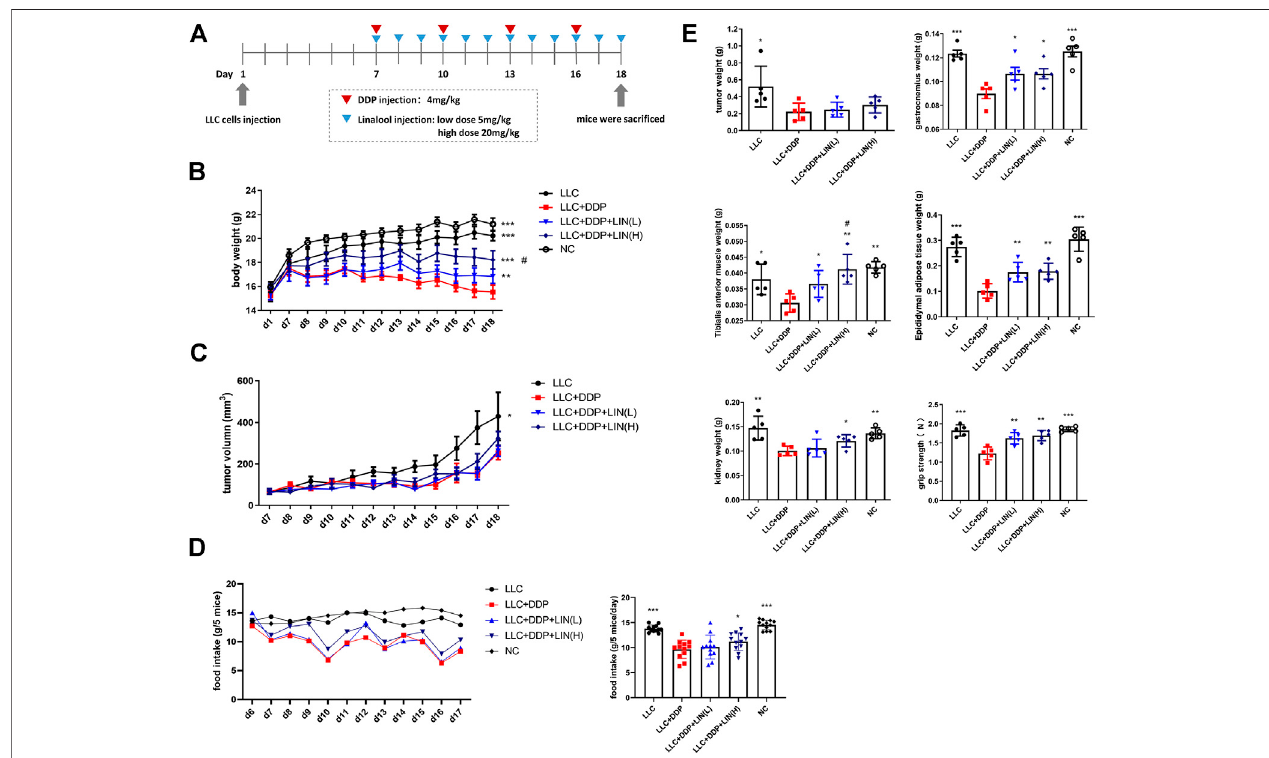
FIGURE 1 | LIN alleviated the decrease of body weight, food intake, muscle, adipose tissue, kidney weight and forelimb grip of tumor bearing mice after DDP treatmentwithoutaffectingtheanti-tumoureffectofDDP (A) 5-week-oldC57BL/6miceweretreatedwithDDP(4 mg kg − 1 · 3 days − 1 ,i.p.)andgivenhighandlowdoseof LIN (5, 20 mg kg − 1 · d − 1 , i.p.) atthe same time lasted for 12 days (B) Bodyweightwasmeasured on day 1and day 7 – 18(n (cid:2) 60); ** p < 0.01, *** p < 0.001vs. LLC +DDP group, # p < 0.05 vs. Group LLC + DDP + LIN(L). (C) The tumor size was measured daily on day 7-18. (D) Food intake of each group of mice was measured daily form one daybeforedosing totheend (left panel). Dataareshown asmean ± S.E.M. (n (cid:2) 12); * p < 0.05, *** p < 0.001 vs.LLC + DDPgroup. (E) Mice weresacri fi ced, the tumor, gastrocnemius muscle, tibial anterior muscle, epididymal fat, and kidney were collected and weighed, and the forelimb grip strength was measured before the mice were sacri fi ced. Data are shown as mean ± S.E.M. (n (cid:2) 5); * p < 0.05, ** p < 0.01, *** p < 0.001 vs. Group LLC + DDP, # p < 0.05 vs. Group LLC + DDP +